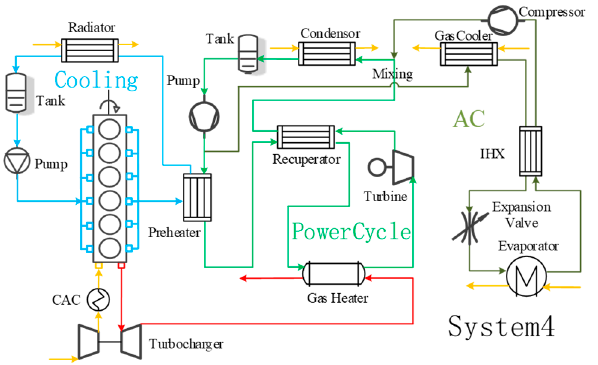
Figure 11. Co-cooling and co-compressing system.